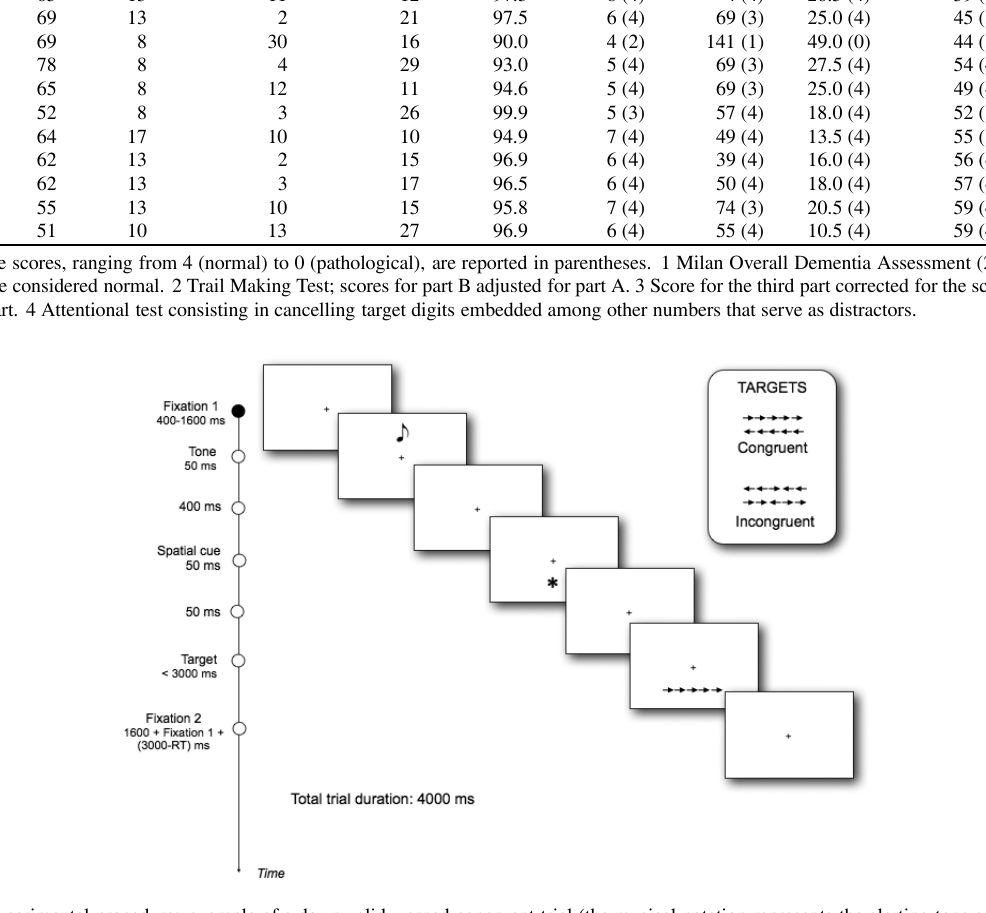
Fig. 1. Experimental procedure: example of a down valid warned congruent trial (the musical notation represents the alerting tone and was not presented